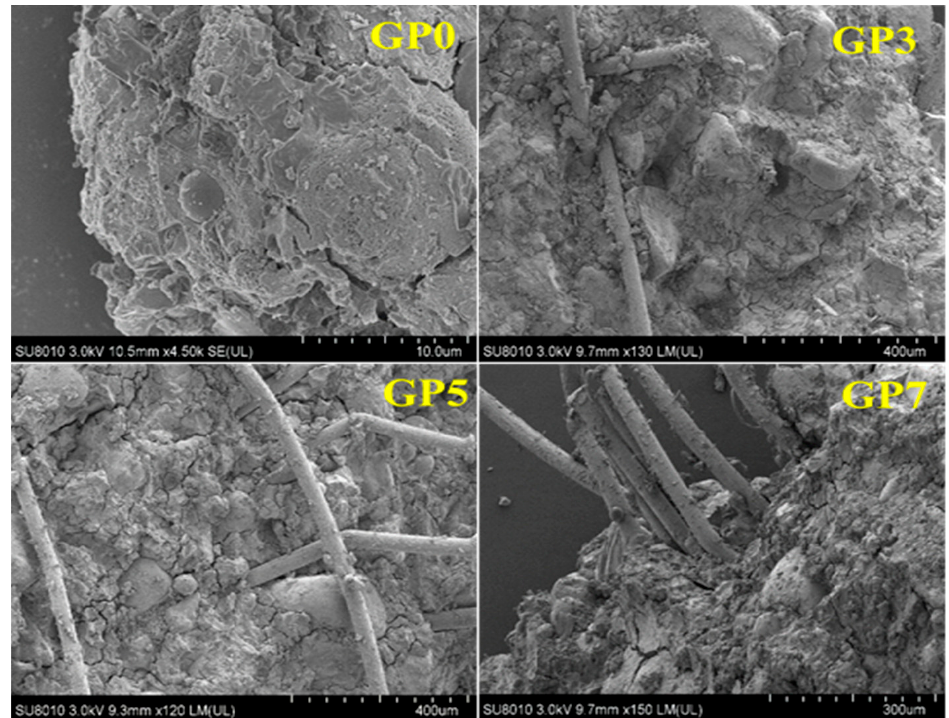
Figure 14. Field emission scanning electron microscopy (FESEM) images of different geopolymers at ambient temperature.